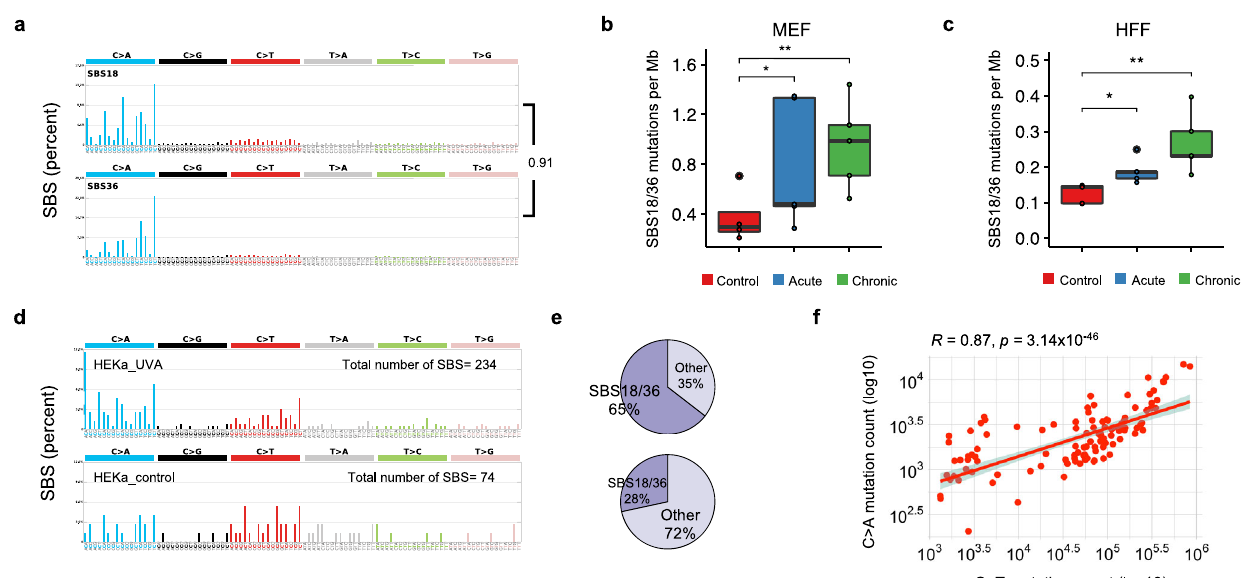
Fig. 7 | Somatic Mutations due to COSMIC signatures SBS18/36 in cells and cancer samples. a The patterns of mutational signatures COSMIC SBS18 and SBS36. b NumberofmutationspermegabaseattributedtoCOSMICSBS18/36inUV exposed MEF clones, per condition, extracted from n =5 biological replicates per condition. c Number of mutation per megabase attributed to COSMIC SBS18/36 in UV exposed HFF clones, per condition, extracted from n =5 biological replicates per condition. d Mutationalpatterns of irradiated (uppertrack) and control (lower